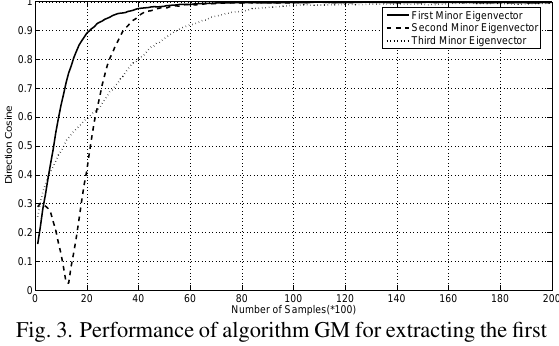
Fig. 3. Performance of algorithm GM for extracting the first three minor